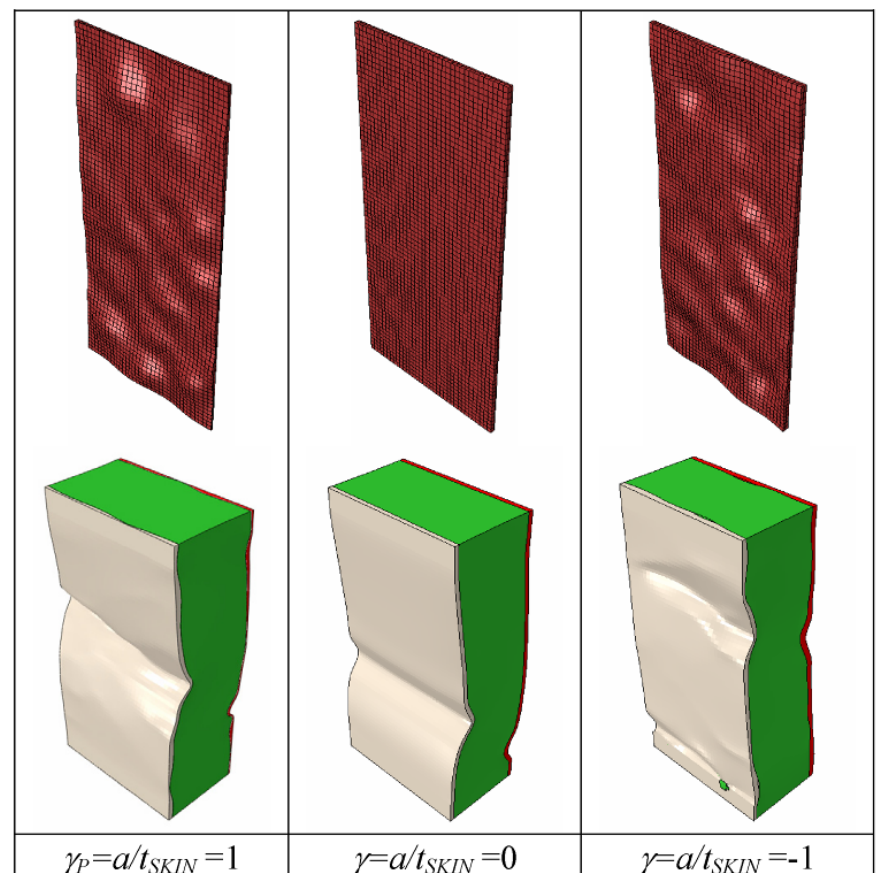
Figure 9. Deformed shapes computed by ABAQUS for γ = γ (flat inner and outer facesheets) and γ = − 1 (core-facesheet interface profile valleys are replaced by peaks and vice versa